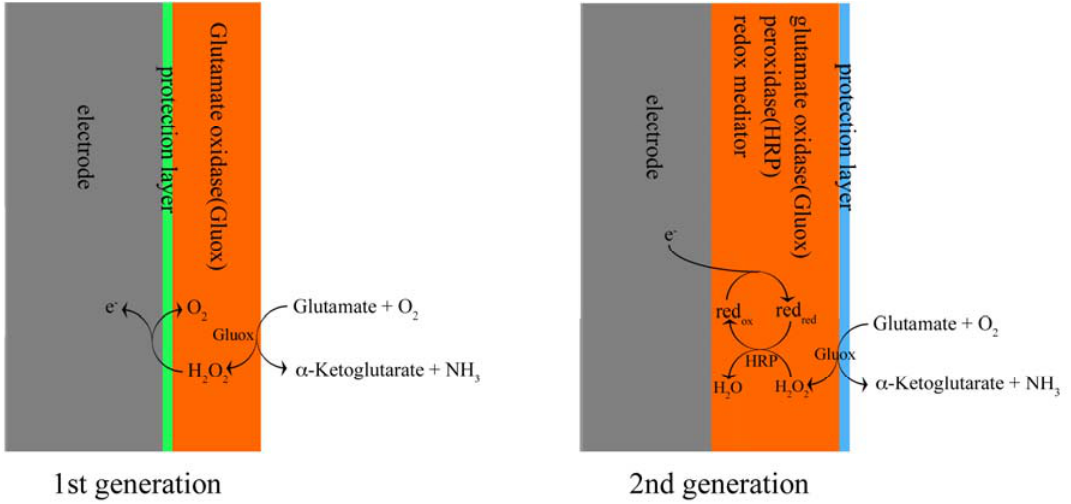
Figure 1. Working mechanisms for first and second generation of glutamate